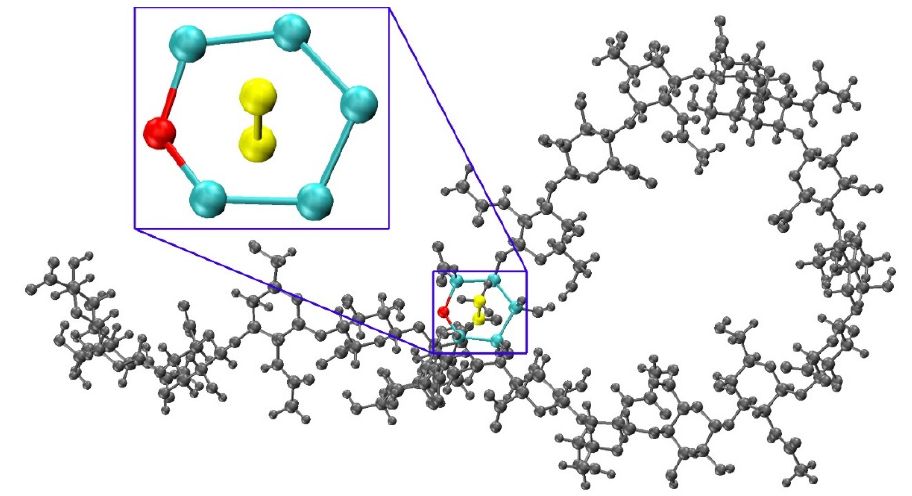
Figure 8. Constructed 20-mer conformation with a GlcA ring pierced by a GalNAc C-CT bond and a close up panel showing atoms involved in the ring pierce; E b = 787.7 kcal / mol, fully-extended 20-mer post-minimization E b = 29.6 kcal / mol, ∆ E b = 758.1 kcal / mol (Table S2).